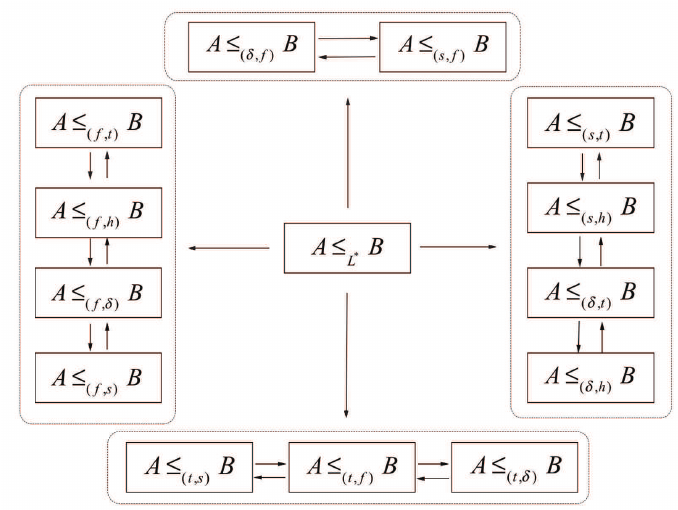
Figure 4. Relationships among lexicographic orders of